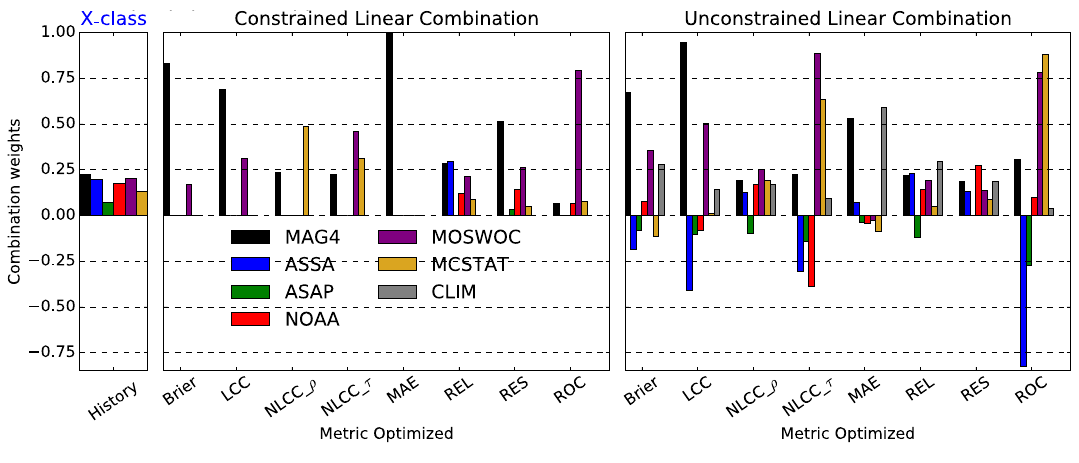
Fig. C.1. Same as Figure 3, but for X-class fl are forecasts.